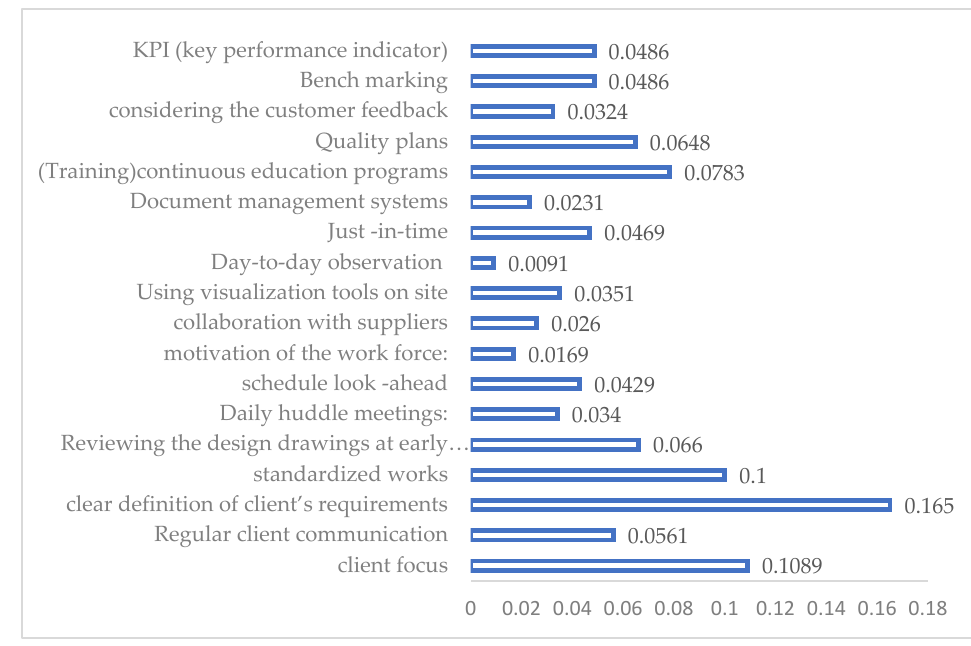
Figure 2 . The global weight of drivers . Figure 2. The global weight of Table 4. Calculation of drivers’ weights.